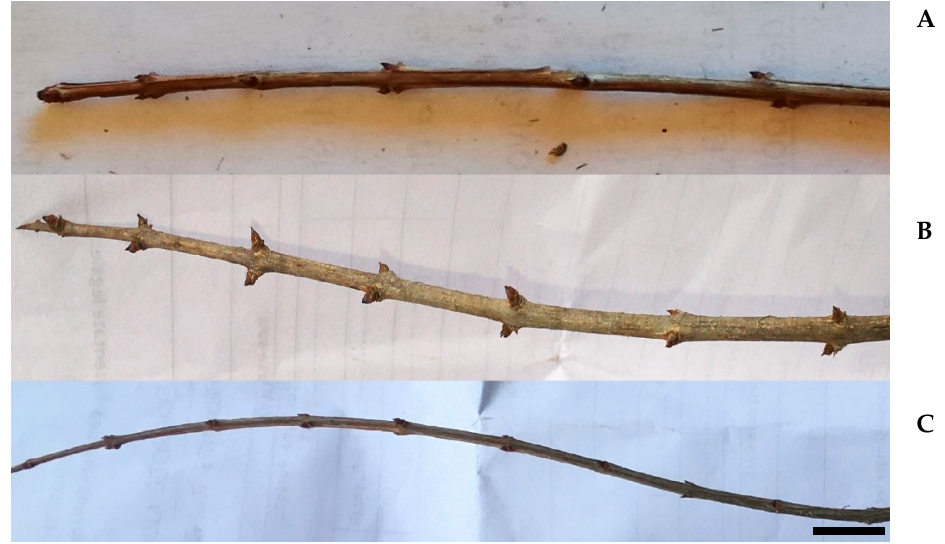
Figure 5. Two buds per node with a rotation of 90° at each successive node for Ki-Zakuro ( A ), Comune S. Giorgio ( B ), and Wonderful ( C ). The scale bar represents 2 cm.